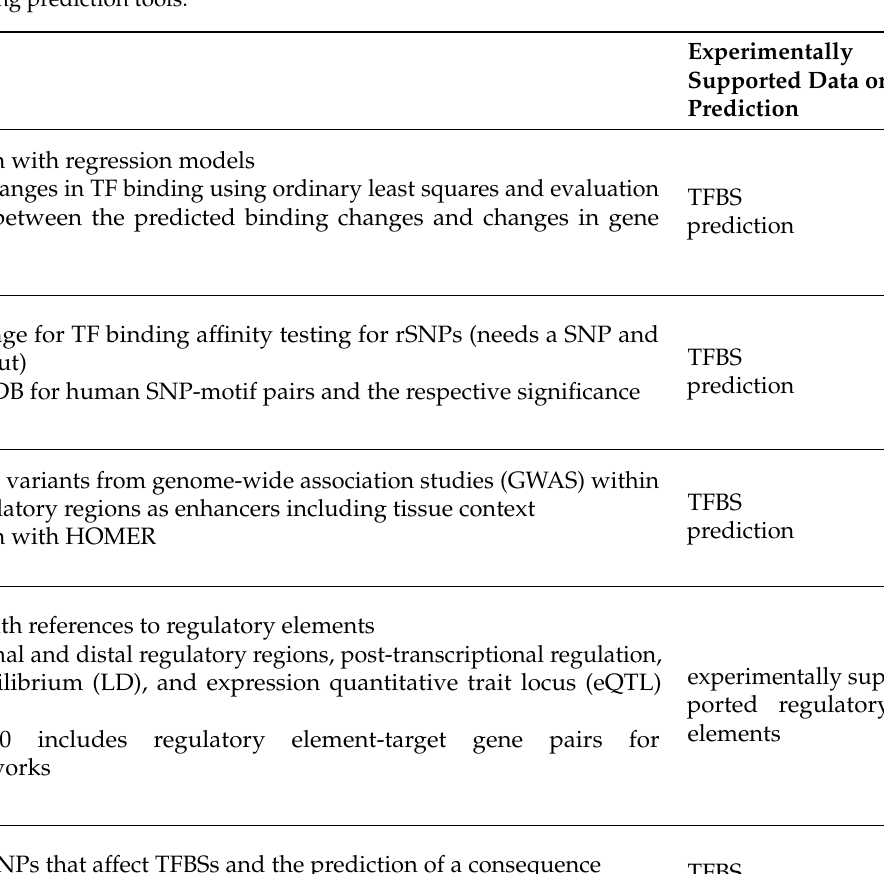
Table 1. A summary of five recent studies that systematically investigated the effects of SNPs on regulatory elements, such as TFBSs. The analyses were done by either collecting experimentally supported and published data or by predicting the SNP impact on TF binding using prediction